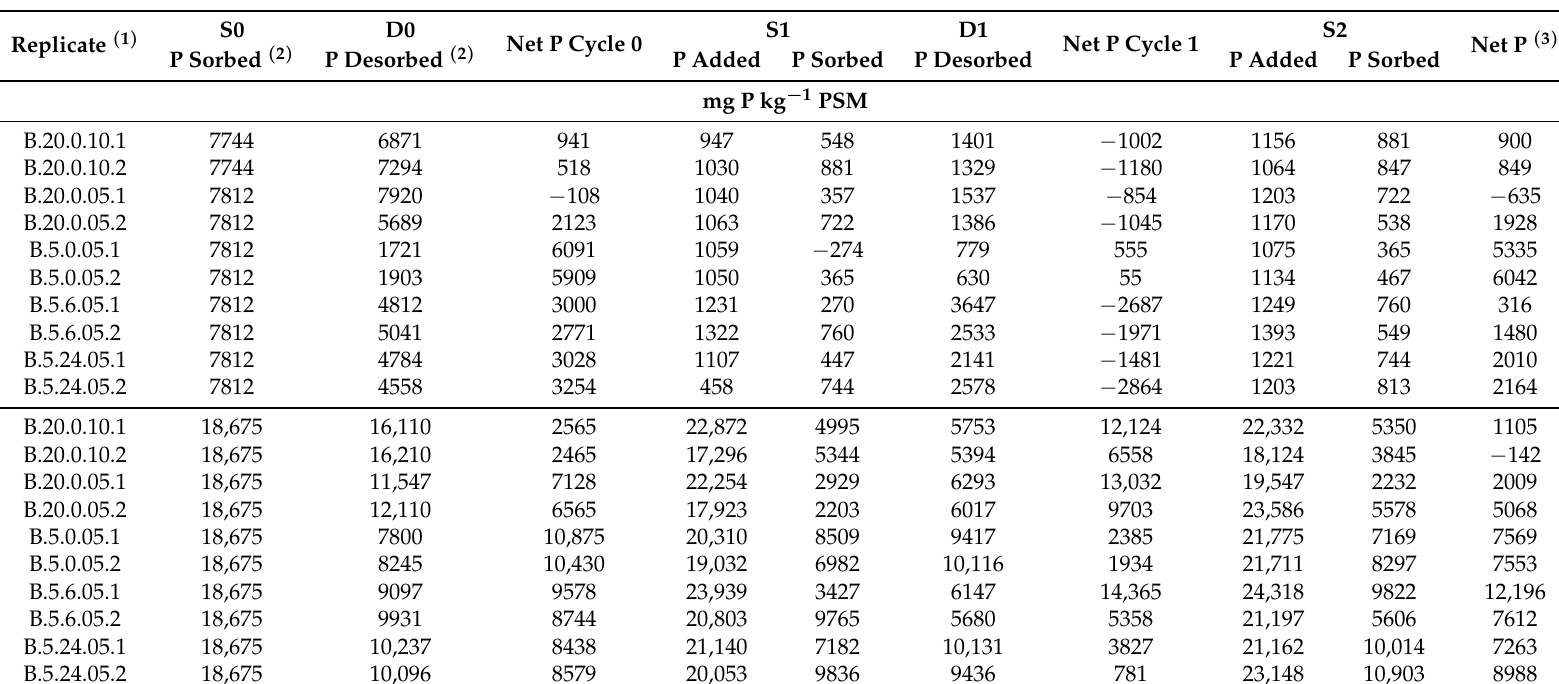
Table A2. Biomax phosphorus (P) sorption and desorption results. Each row represents one regeneration treatment. The first ten rows refer to 0.5 mg L − 1 P, the second ten are 50 mg L − 1 P